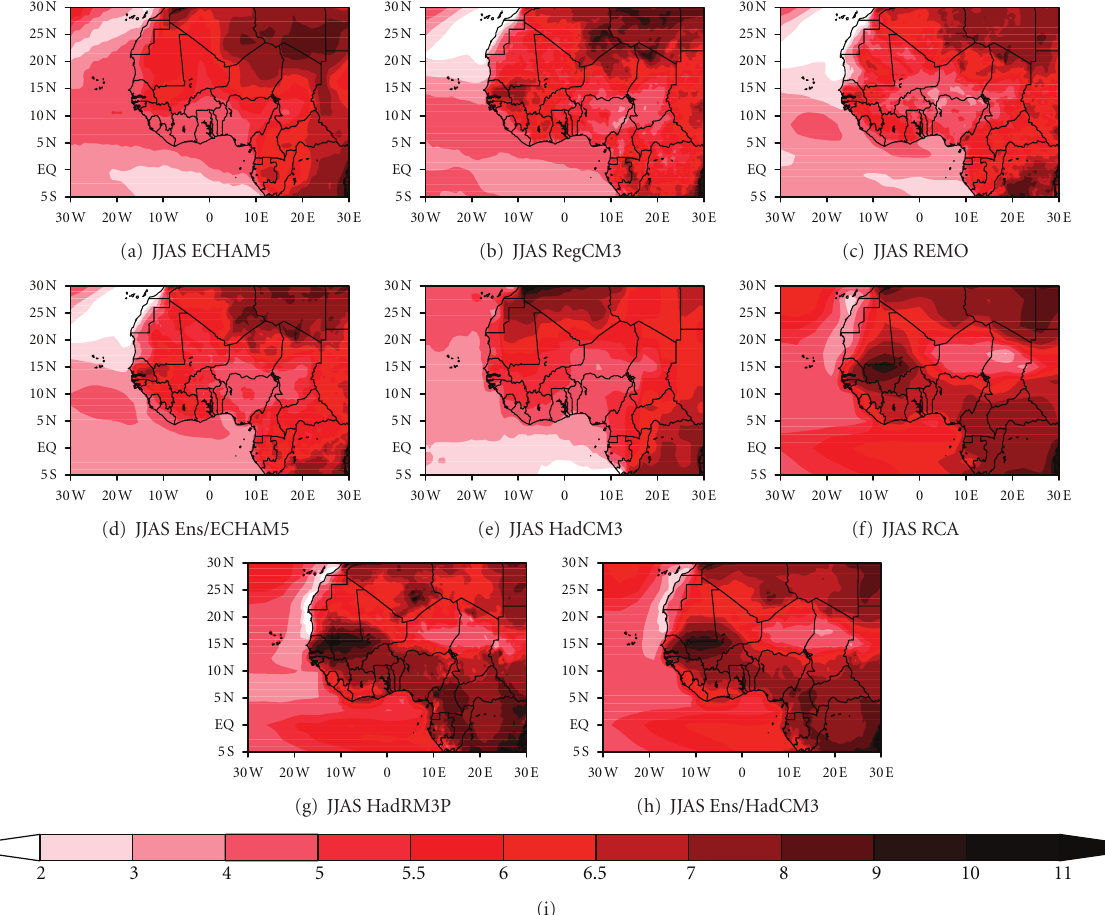
Figure 10: Averaged JJAS di ff erence between the future (A1B: 2031–2050) and the reference period (1981–2000) of precipitation from: (a) ECHAM5, (b) RegCM3, (c) REMO, (d) Ens/ECHAM5 (mean ensemble of RCMs driven by ECHAM5), (e) HadCM3, (f) RCA, (g) HadRM3P, and (h) Ens/HadCM3 (mean ensemble of RCM driven by HadCM3). Precipitation change are in % of present day values and areas where reference mean precipitation is less than 0.5mm/day have been masked out. Contours represent where the changes are significant at 90%